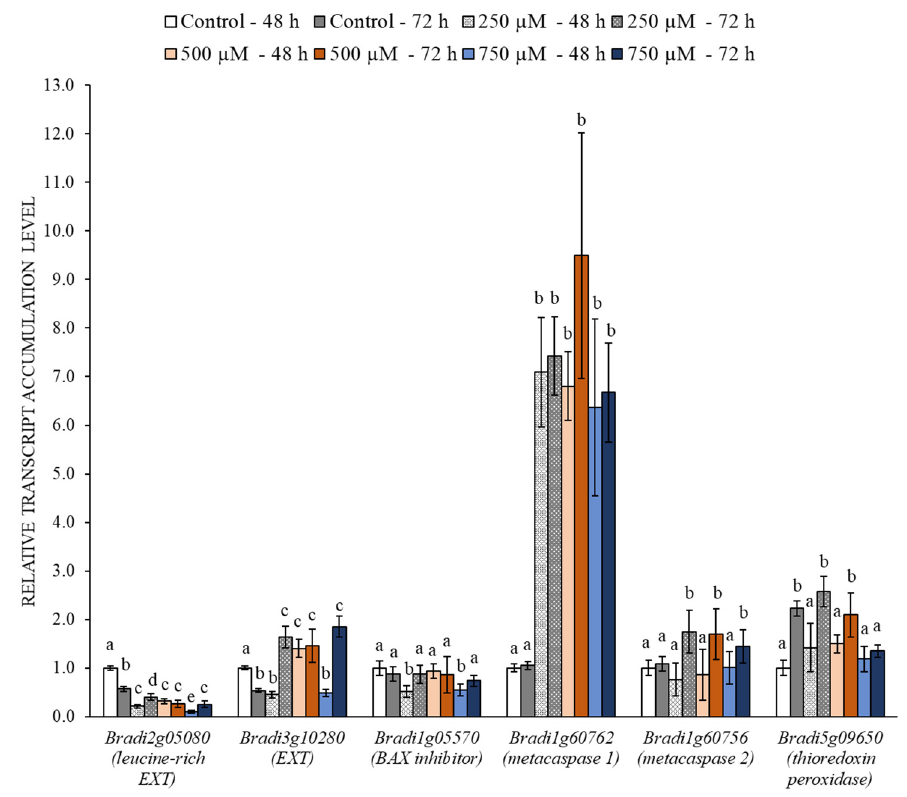
Figure 5. The relative level of transcript accumulation of EXTs and PCD-related genes. The relative expression levels were normalized to an internal control ( AK437296 , gene encoding ubiquitin). Statistically significant differences are indicated by different letters (ANOVA followed by the Tukey HSD test, p < 0.05; mean ± SD).